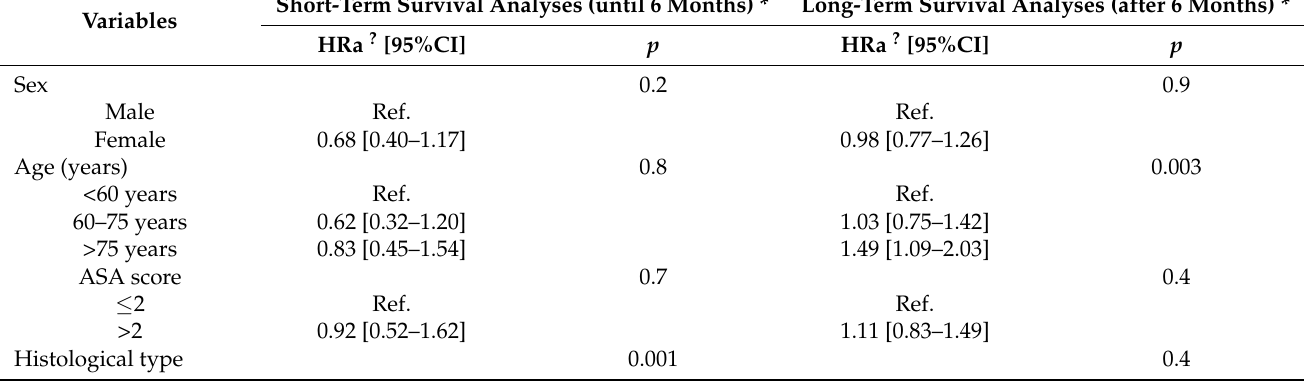
Table 4. Multivariate flexible survival analyses of short- and long-term survival (with only 3 patients, the grade A PPH group does not appear in the